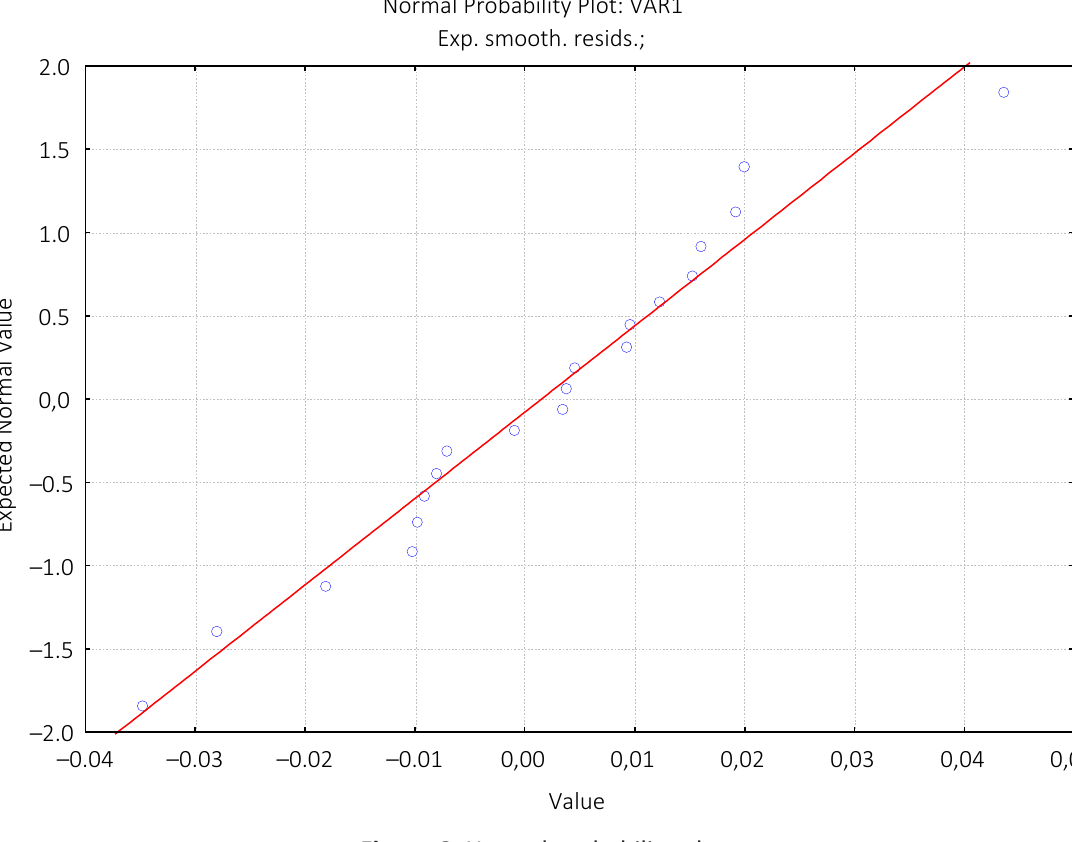
Normal Probability Plot: